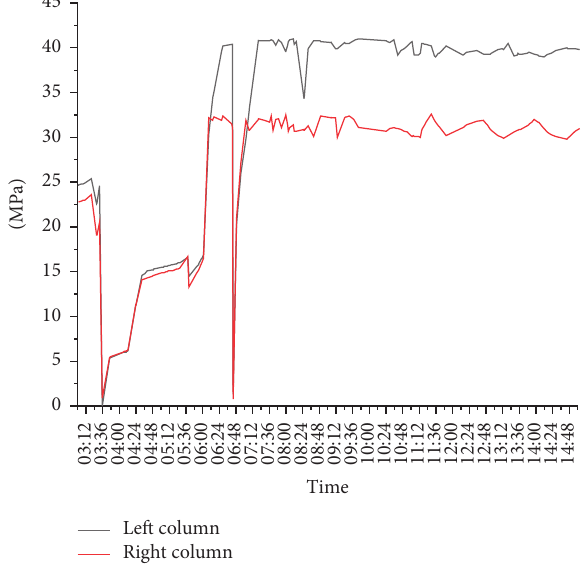
Figure 6: Real-time pressure history curve of 64#